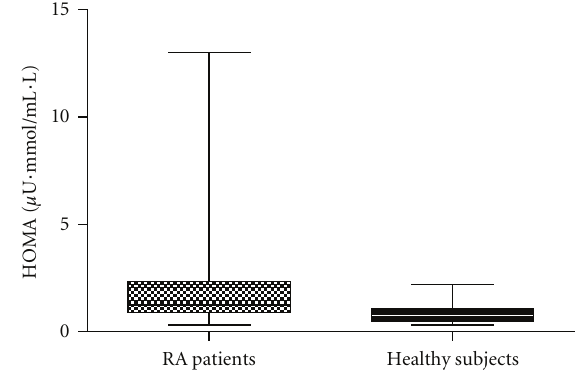
Figure 1: Homeostasis model assessment (HOMA) index in serum samples. Box plot graphs show HOMA index in serum samples from the 30 patients with rheumatoid arthritis (RA) and 10 healthy subjects. The P value was